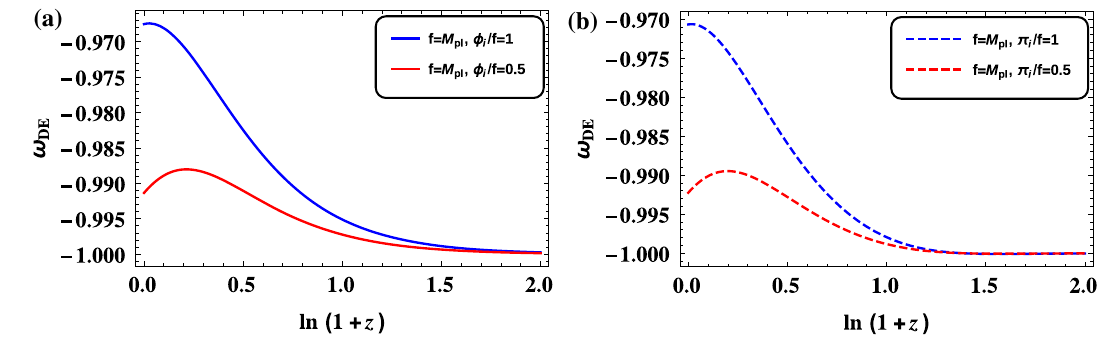
Fig. 3 a (Leftpanel)Variationsofdarkenergyequationofstateparam- eter with redshift for general quintessence dark energy model, consid- ering different initial values of φ . b (Right panel) Variations of dark f